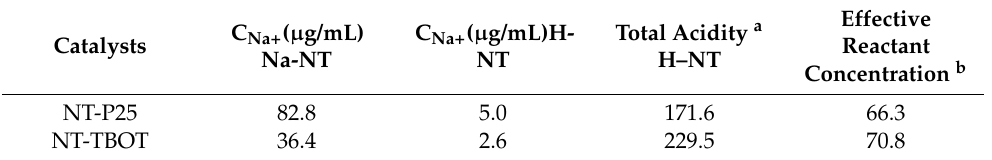
Table 2. Comparison of Na content and total